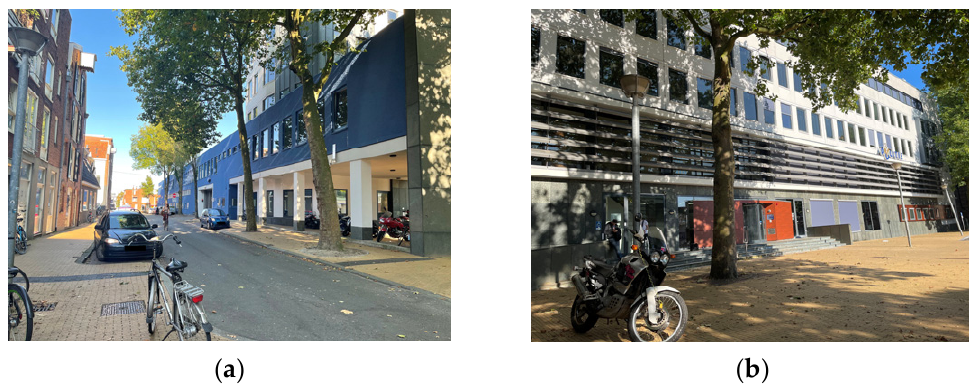
Figure 1. ( a ) North façade and surroundings; ( b ) west façade.